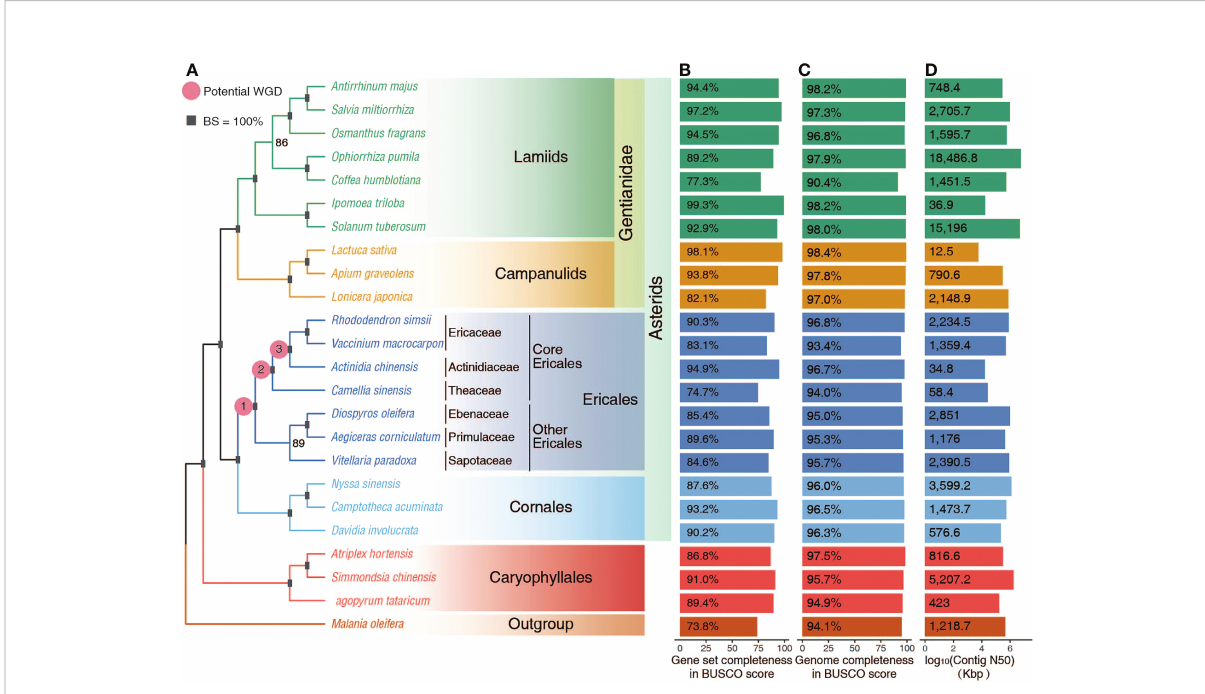
FIGURE 1 Whole genome data collected. (A) The inferred ML phylogeny of representative Superasterids based on the concatenated alignment of amino acid sequences of 532 orthogroups. Squares represent 100% bootstrap support (BS) values for nodes. The three pink dots represent the three possible WGD events identi fi ed in previous reports. (B, C) Completeness of genome assembly and gene annotation as re fl ected in Benchmarking Universal Single Copy Orthologs (BUSCO) scores. (D) Contig N50 of whole genome